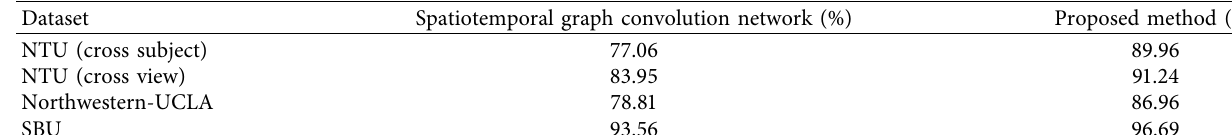
Table 3: Experimental results of different models.